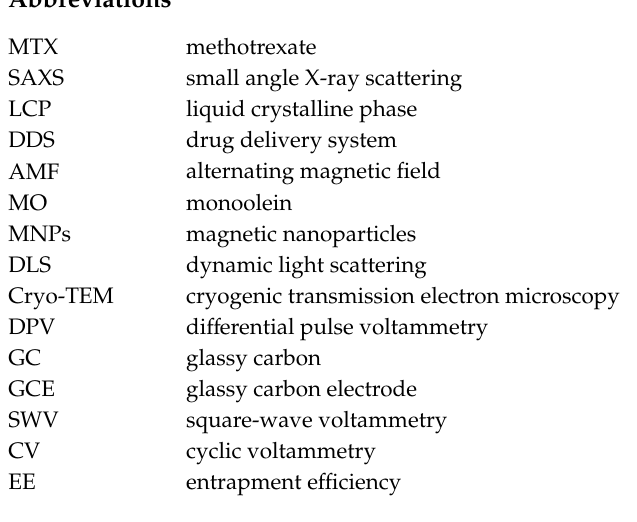
Figure S1: Scheme of chemical structure of methotrexate (MTX) and folic acid (FA). S2: Equations used for the determination of Symmetry, lattice parameter, lipid length and diameter of water channels of the cubic phases. Figure S3: Scheme of the reduction process of methotrexate. Figure S4: Release profiles of MTX from a cubic phase in pH 7.4 at 25 and 37 ◦ C. Figure S5: DPV on GC electrode modified with phases without and with magnetic nanoparticles and the release profiles of MTX from LCPs at pH 7.4 at 25 ◦ C. Figure S6: The size and zeta potential of magnetocubosomes containing MTX determined with DLS at 25 ◦ C. Figure S7: Standard calibration curve for methotrexate based on measurement at 303 nm in 0.1 M phosphate bu ff er, pH 7.4. Figure S8: Electron cryo-microscopy images of cubosomes and magnetocubosome. Video S9: Movement of magnetocubosomes in magnetic